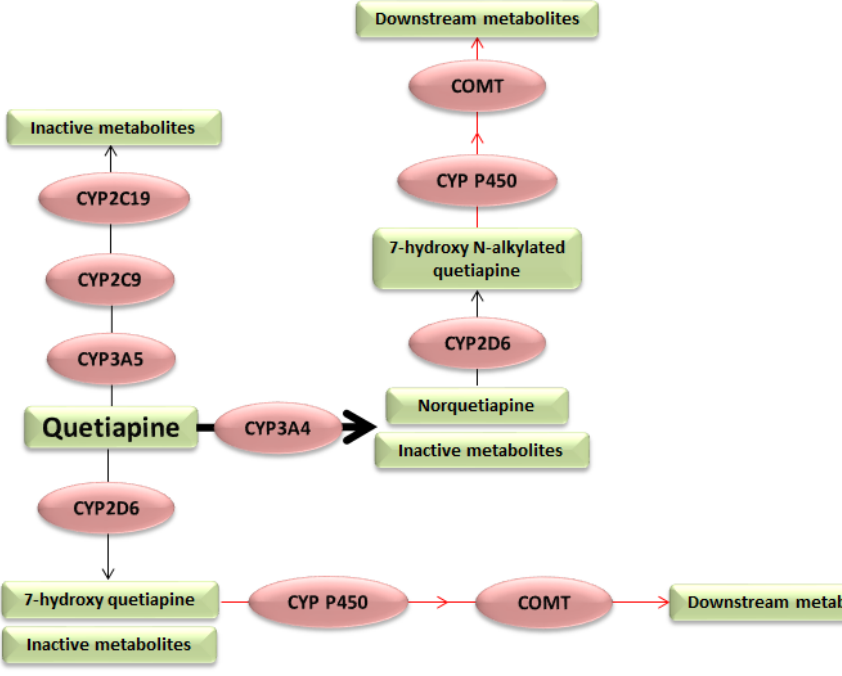
Figure 1. Genes involved in quetiapine metabolism. Red arrows indicate a recently suggested pathway that requires additional studies. CYP3A5 : Cytochrome P450 Family 3 Subfamily A Member 5, CYP2C19 : Cytochrome P450 Family 2 Subfamily C Member 19, CYP2C9 : Cytochrome P450 Family 2 Subfamily C Member 9, CYP3A5 : Cytochrome P450 Family 3 Subfamily A Member 4, CYP3A5 : Cytochrome P450 Family 2 Subfamily D Member 6, COMT: Catechol-O-methyltransfer- ase.